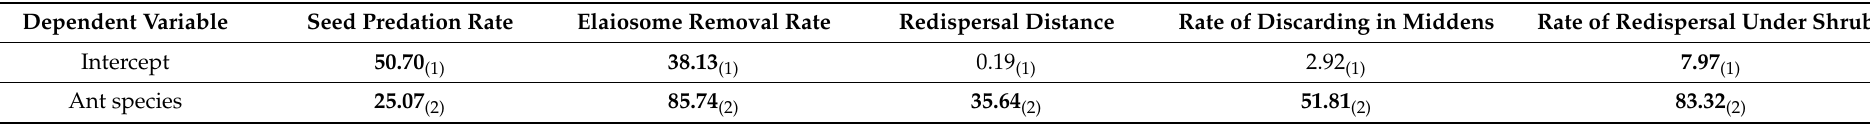
Table A2. Summary of the GLMs testing the effect of ant species on variables of seed fate and final location—presented are the χ 2 values with df in parentheses; significant effects are in